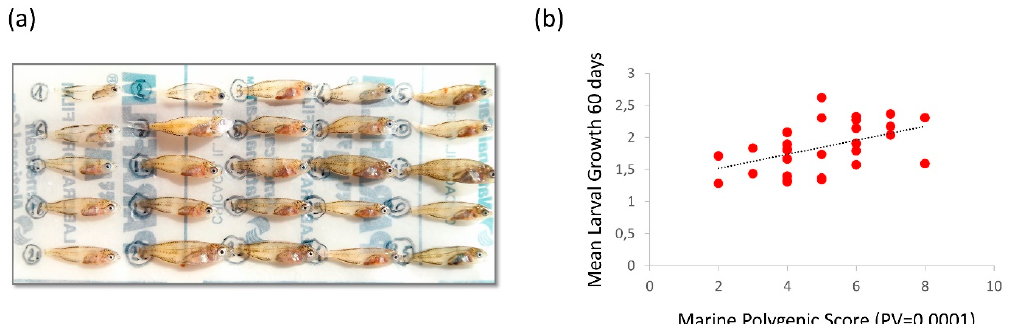
Figure 5. Phenotypic variance explained by outlier loci in the independent sample of larvae. ( a ) Picture of larvae collected on the same day, showing differences in size between individuals. ( b ) Positive correlation ( R 2 = 0.214, slope P = 0.01) between the average daily width increment of otolith rings during the first 60 days of larval life (y axis, in µm per day) and the marine polygenic score calculated for the 11 most significant outliers found in the SGS test (x axis, P -value threshold of 0.0001).